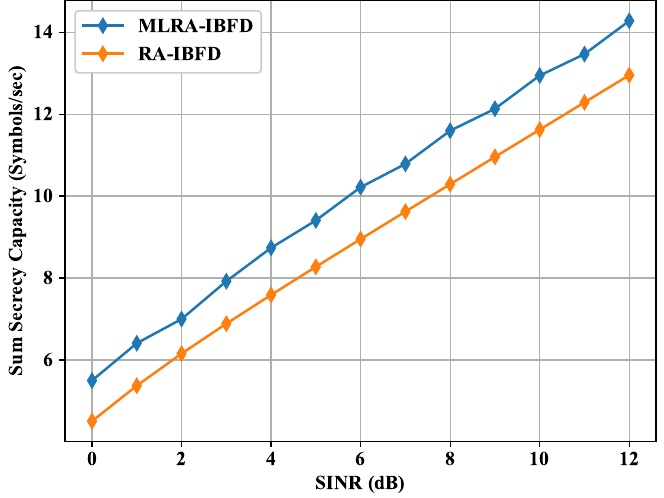
Figure 7. Sum secrecy capacity comparison for Proposed RA-IBFD and R-IBFD with R-HD, RA-HD and NOMA.